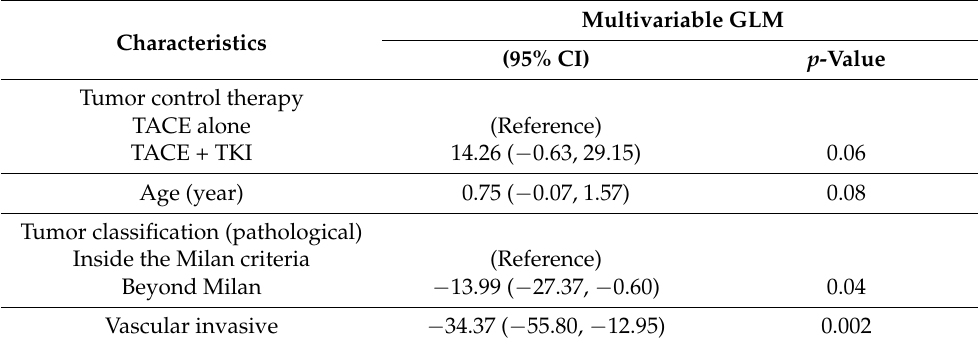
Table 2. Characteristics associated with the percent of tumor necrosis on explant